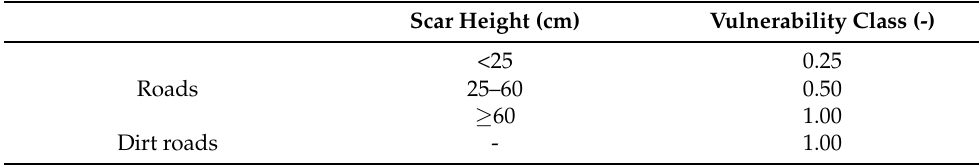
Table 4. Vulnerability levels for roads. For primary roads, the values depend on the height of the scar; for dirt roads, the vulnerability is set to 1.00 regardless of the expected